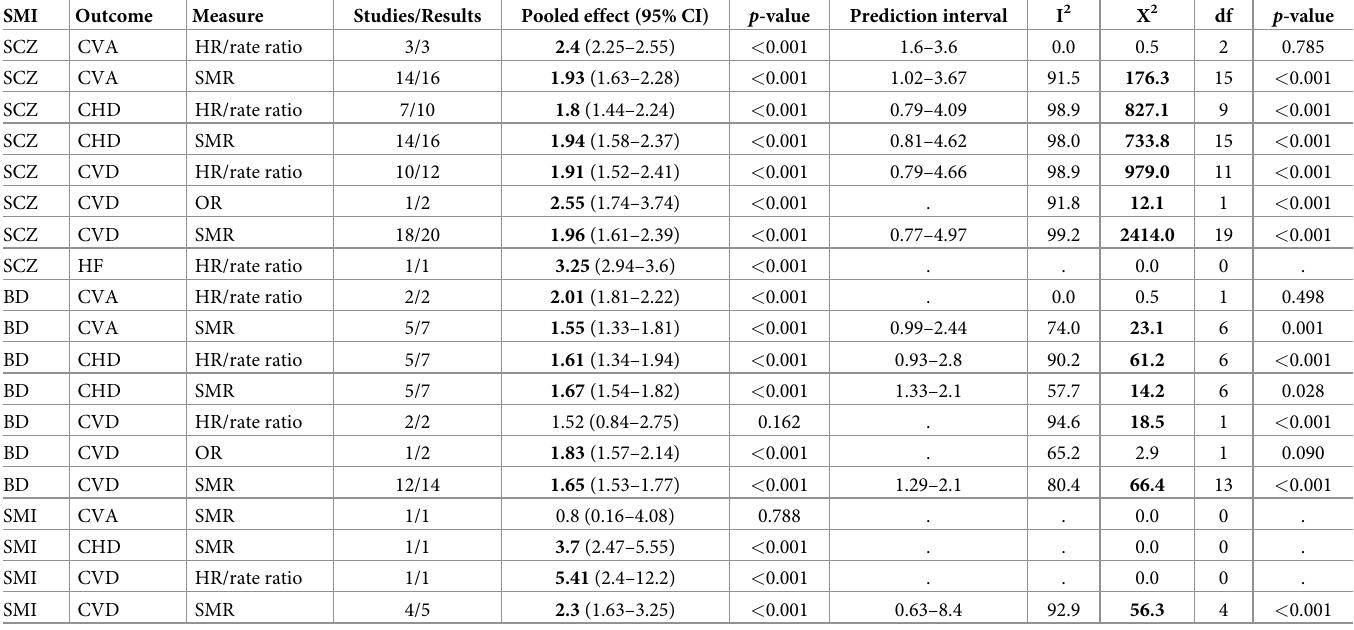
Table 1. Pooled relative risks of cardiovascular mortality by SMI and cardiovascular outcome. SMI Outcome